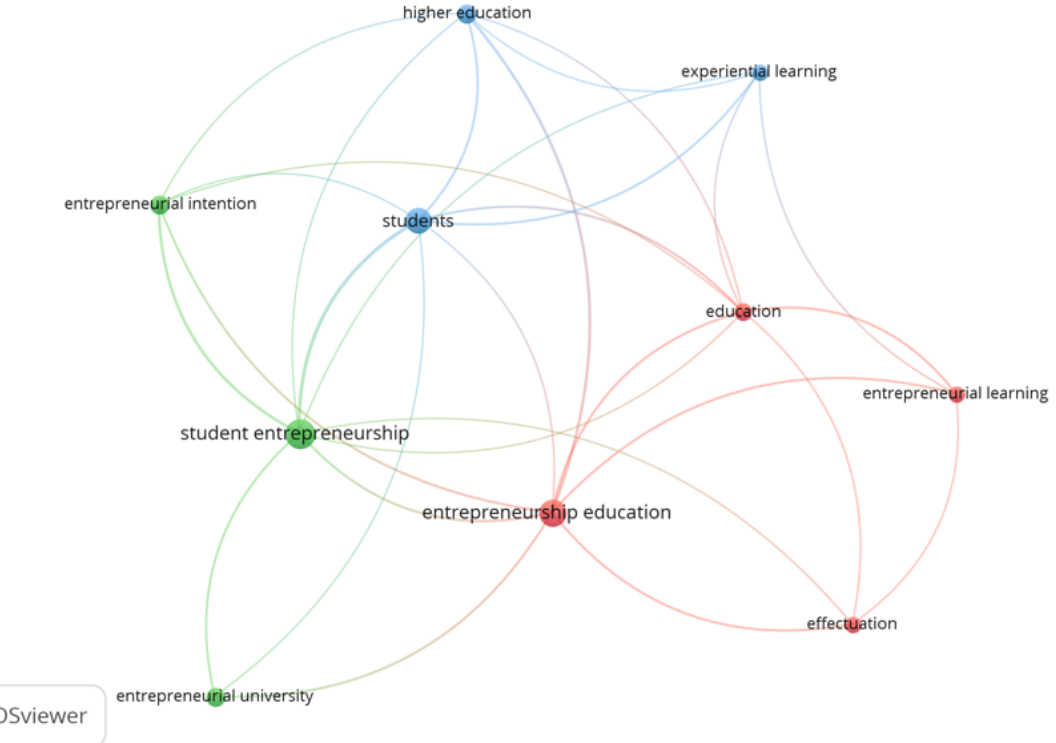
Figure 2. Clusters by keywords’ occurrence.